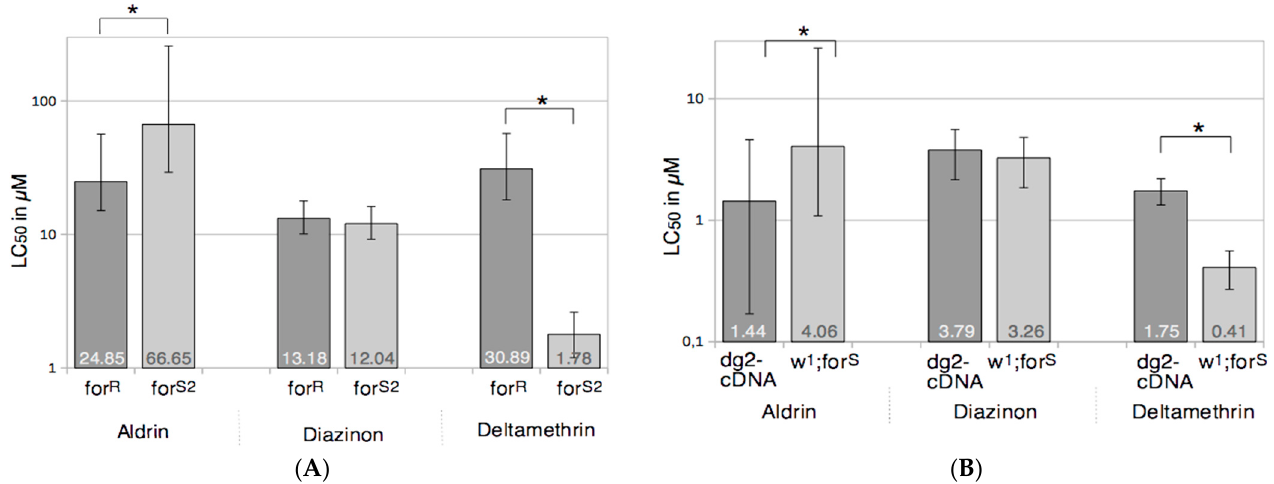
Figure 2. LC50 values of rover and sitter strains for three insecticides. Bar charts represent the LC50 values of the forR and forS2 strains (panel A ) and the dg2 -cDNA and w1;forS strains (panel B ). LC50 values are shown in the bars and are expressed in the same units as the insecticide concentrations of the acetonic solutions used to coat the tubes. Vertical bars represent 95% fiducial limits of the LC50 values. Dark grey boxes indicate rover strains and light grey boxes indicate the sitter strains. * indicate significantly different LC50 values.